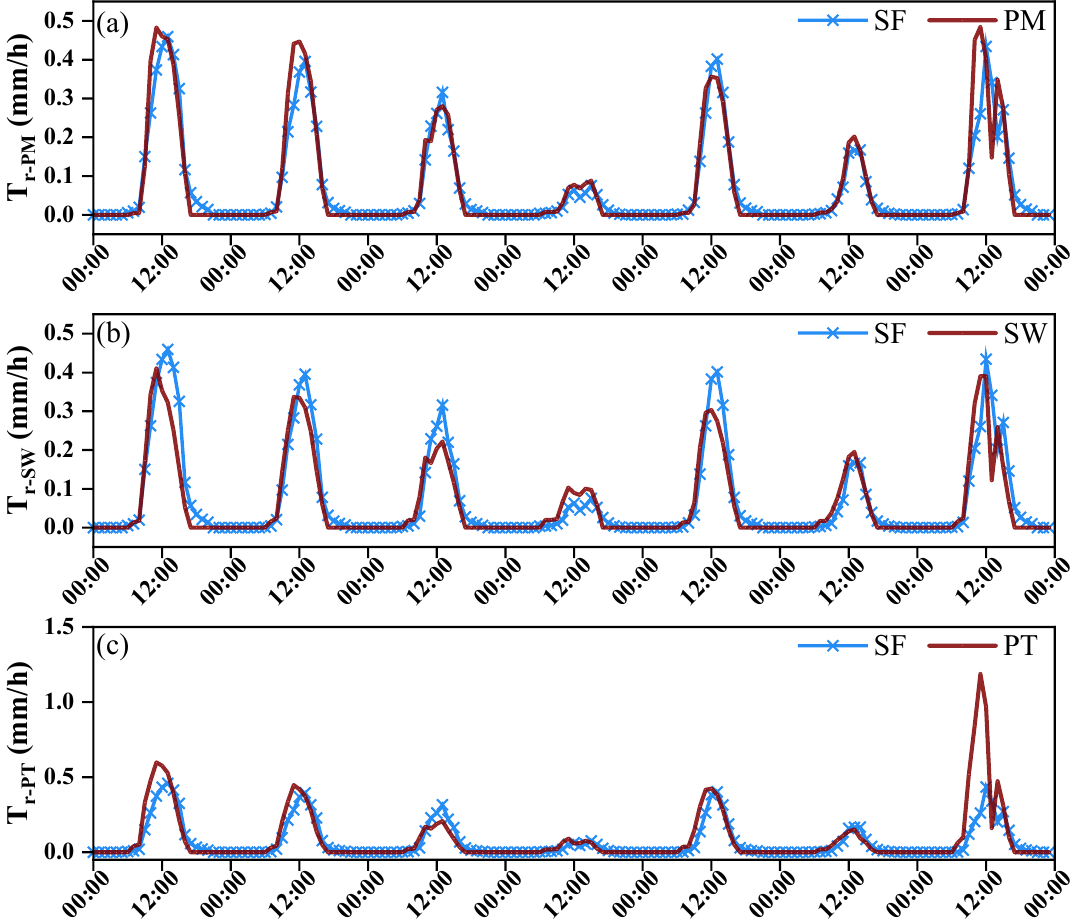
Figure 6. Daily courses of the simulated hourly Tr values by the PM ( a ), SW ( b ) and calibrated PT ( c ) models and the measured sap flow (SF) during the seven sample days from 4–10 November in the 2019 winter season.